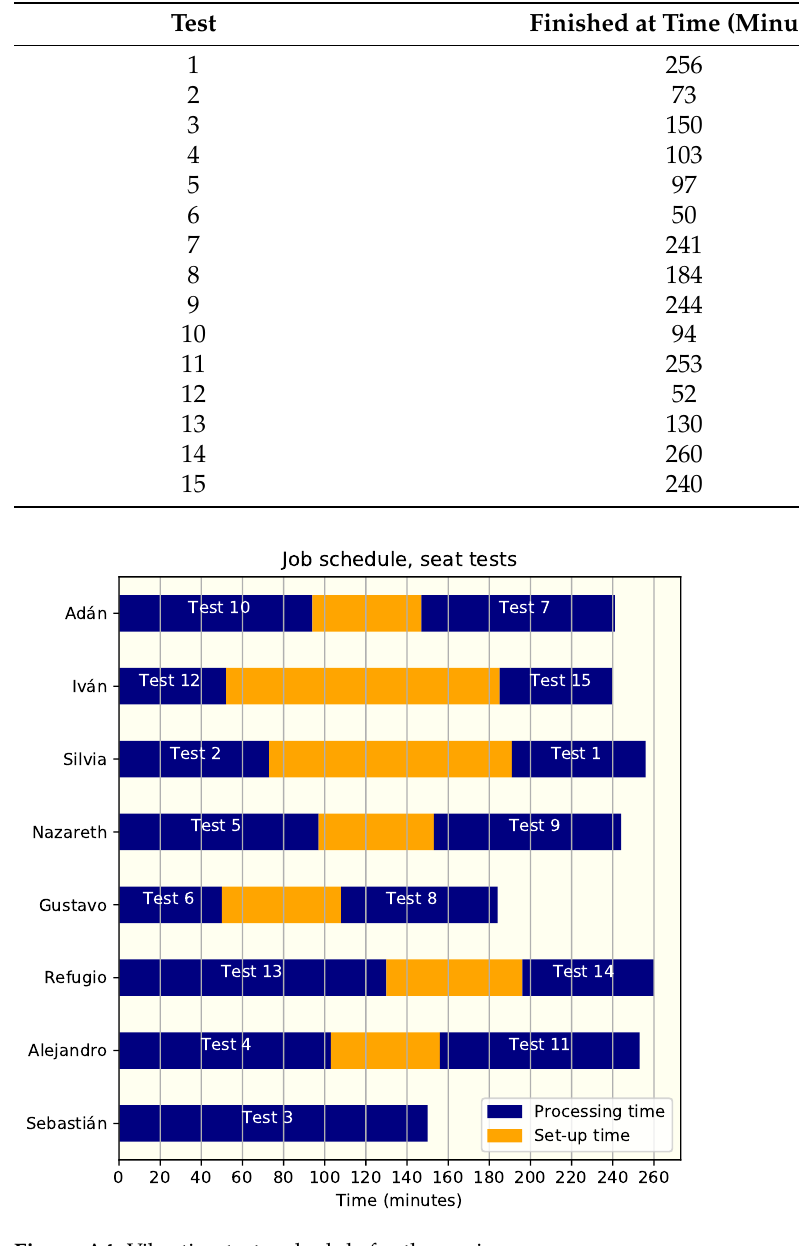
Figure A4. Vibration tests schedule for the